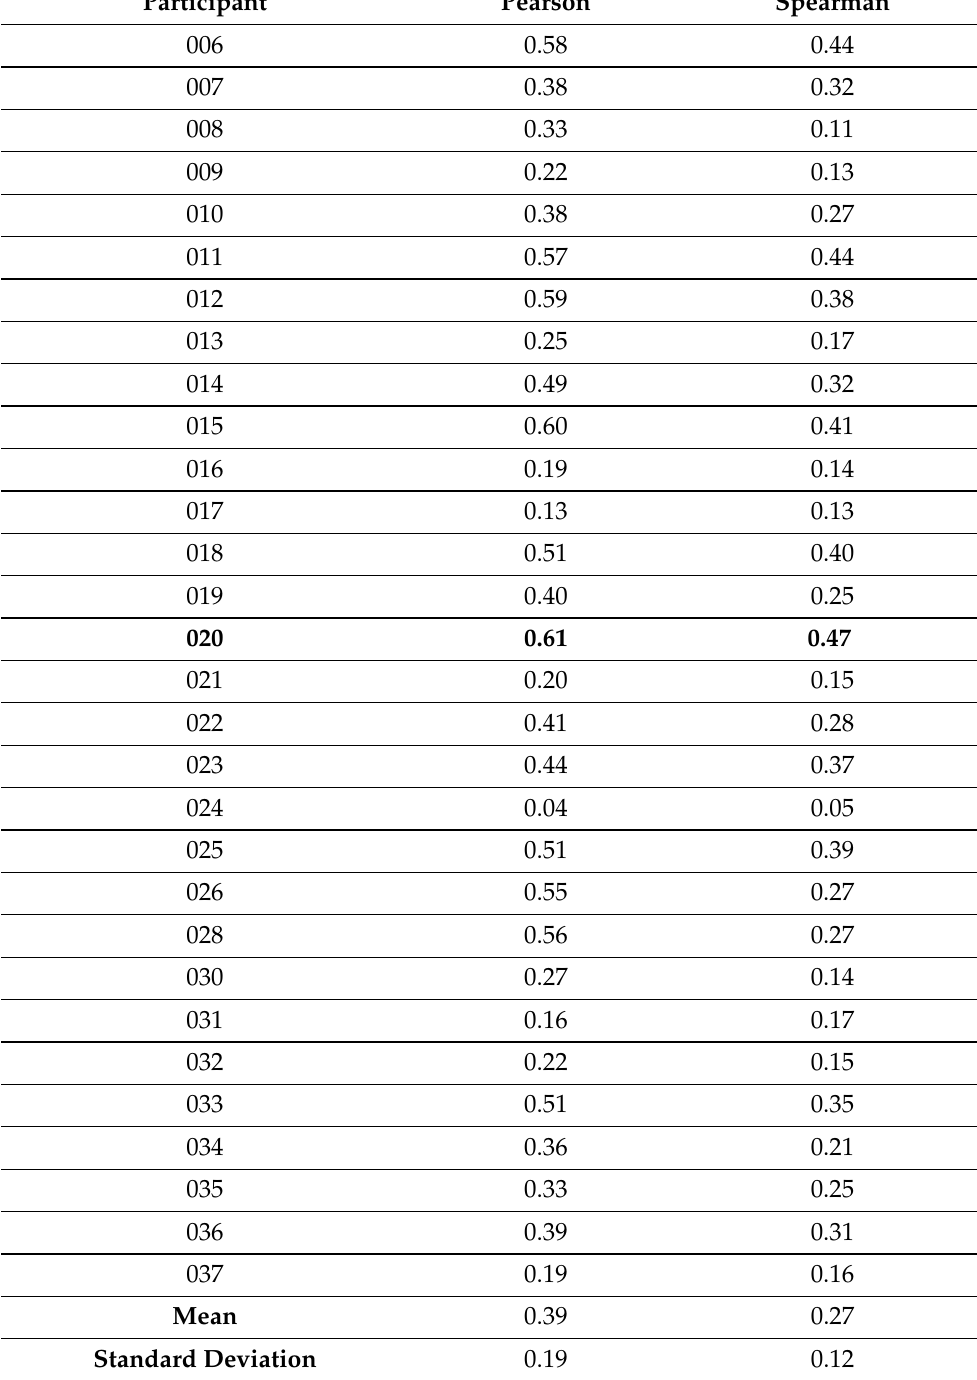
Table 2. Analysis of the quality for each participant of SAMM-LV versus SAMM-SYNTH. Both Pearson’s and Spearman’s correlation are compared. Participant 020 (in bold) ranked the highest, while Participant 024 ranked the